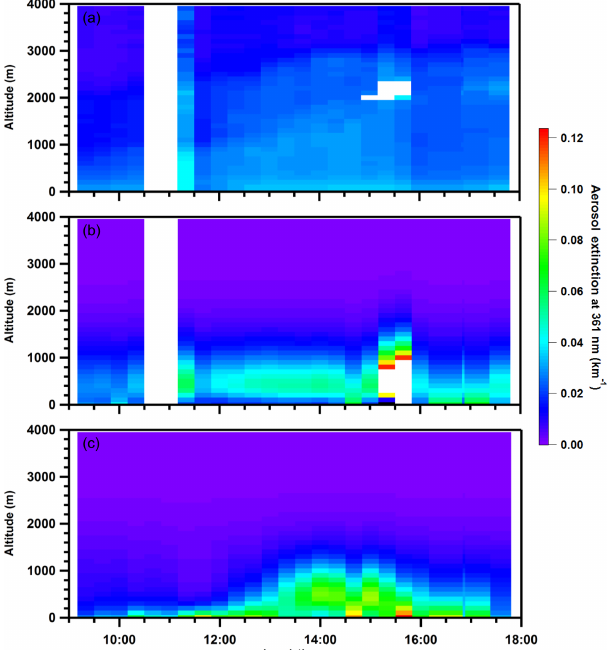
Figure 14. The 3 September vertical profiles of aerosol extinction (361nm) from averaged lidar (a) , smoothed lidar (b) , and MAX- DOAS retrieved measurements (c) .